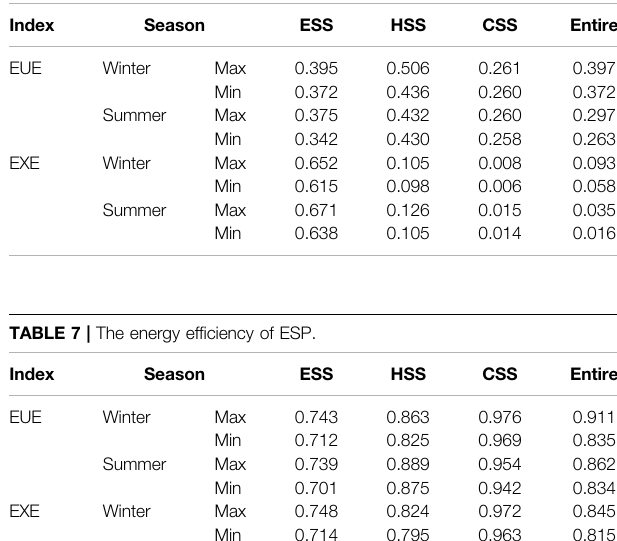
TABLE 6 | The energy ef fi ciency of ECP.